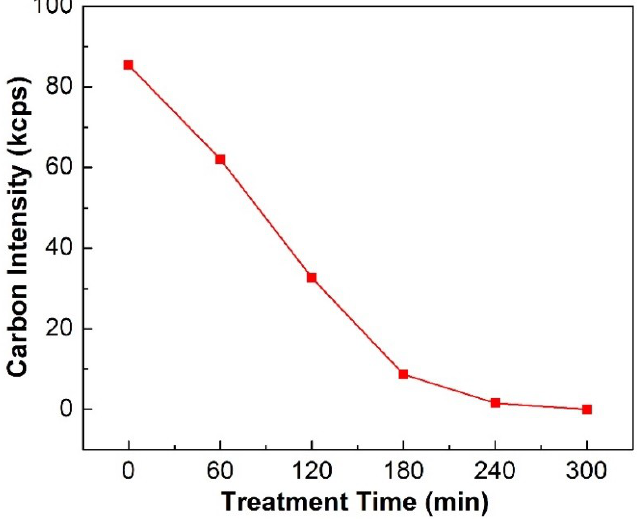
Figure 10. Variation of intensity of the 26.4 degree peak in the XRD patterns for SiC powder products with different carbon removal treatment times.